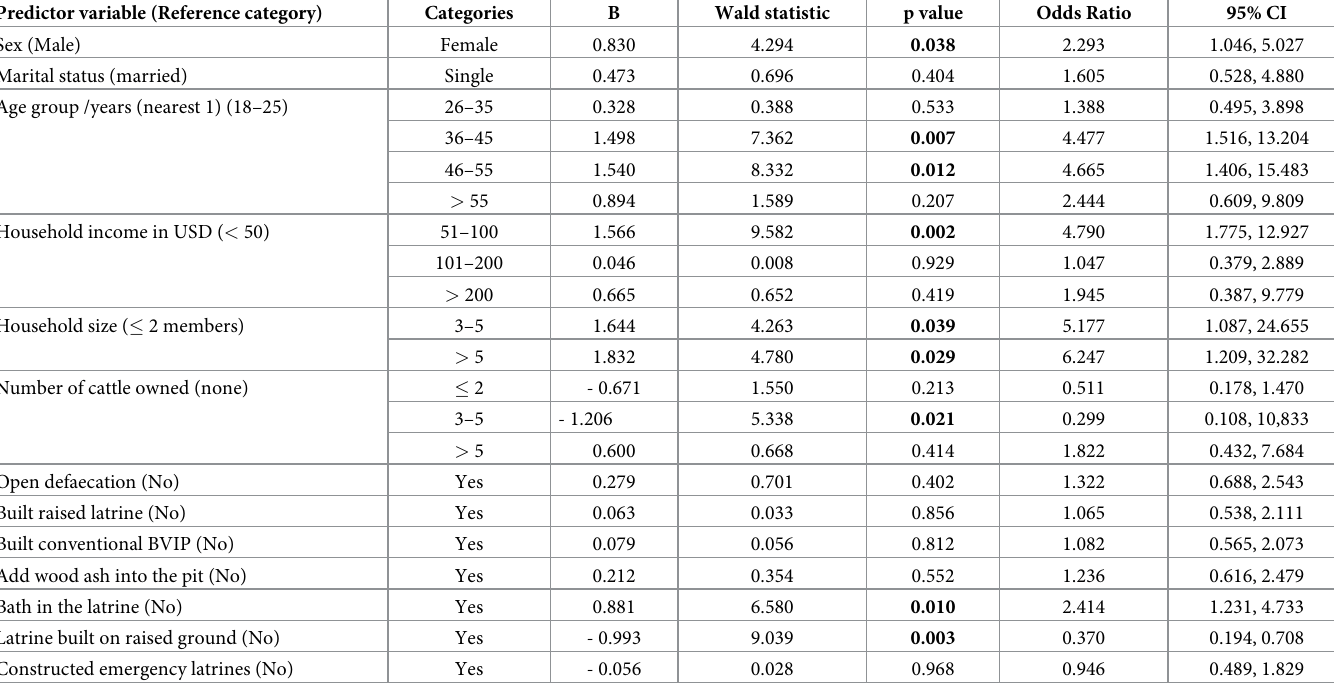
Table 4. Binomial logistic regression model showing the effect of individual, household and technology-level predictors on the intention to adapt a BVIP latrine to climate change for rural households in Mbire district, northern Zimbabwe (n =